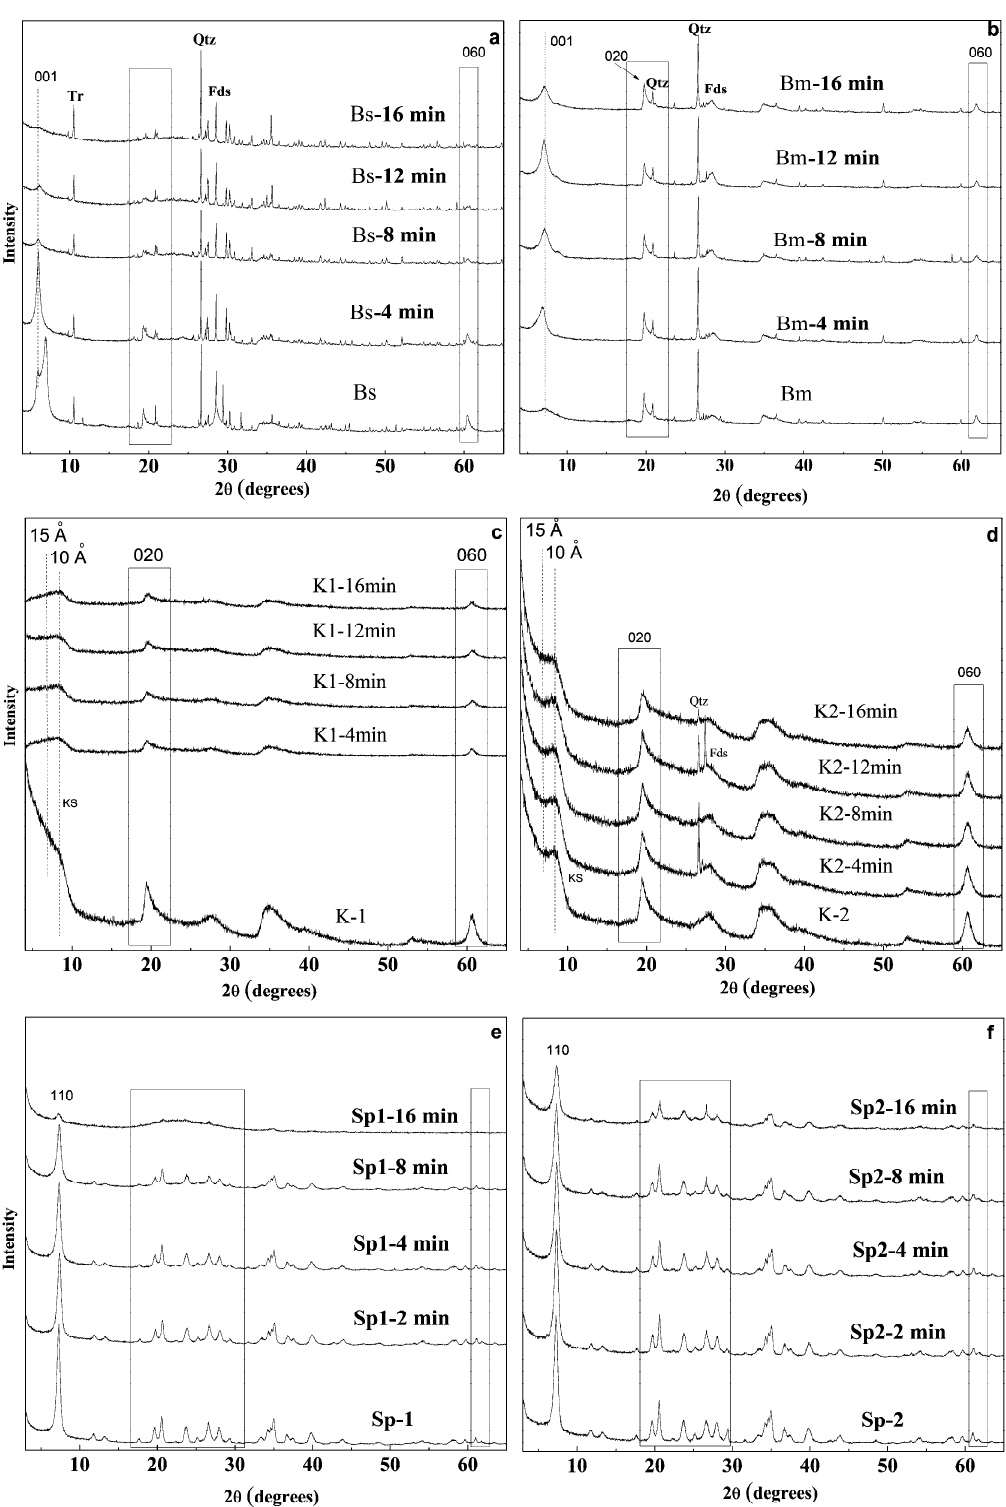
Figure 2. X-ray diffraction patterns of Bs ( a ), Bm ( b ), K1 ( c ), K2 ( d ), Sp1 ( e ) and Sp2 ( f ) and acid-treated samples. Qtz: Quartz; Fds: Feldspars; Tr: Tremolite.